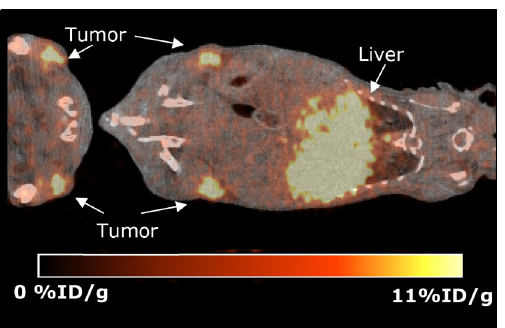
Figure 2. In vivo, AM, PET scan of a dual-flank U-87 MG tumor-bearing mouse 5 days after injection of 1.9 MBq of 134 Ce-cDTPA-ATN291, 900 s acquisition time.